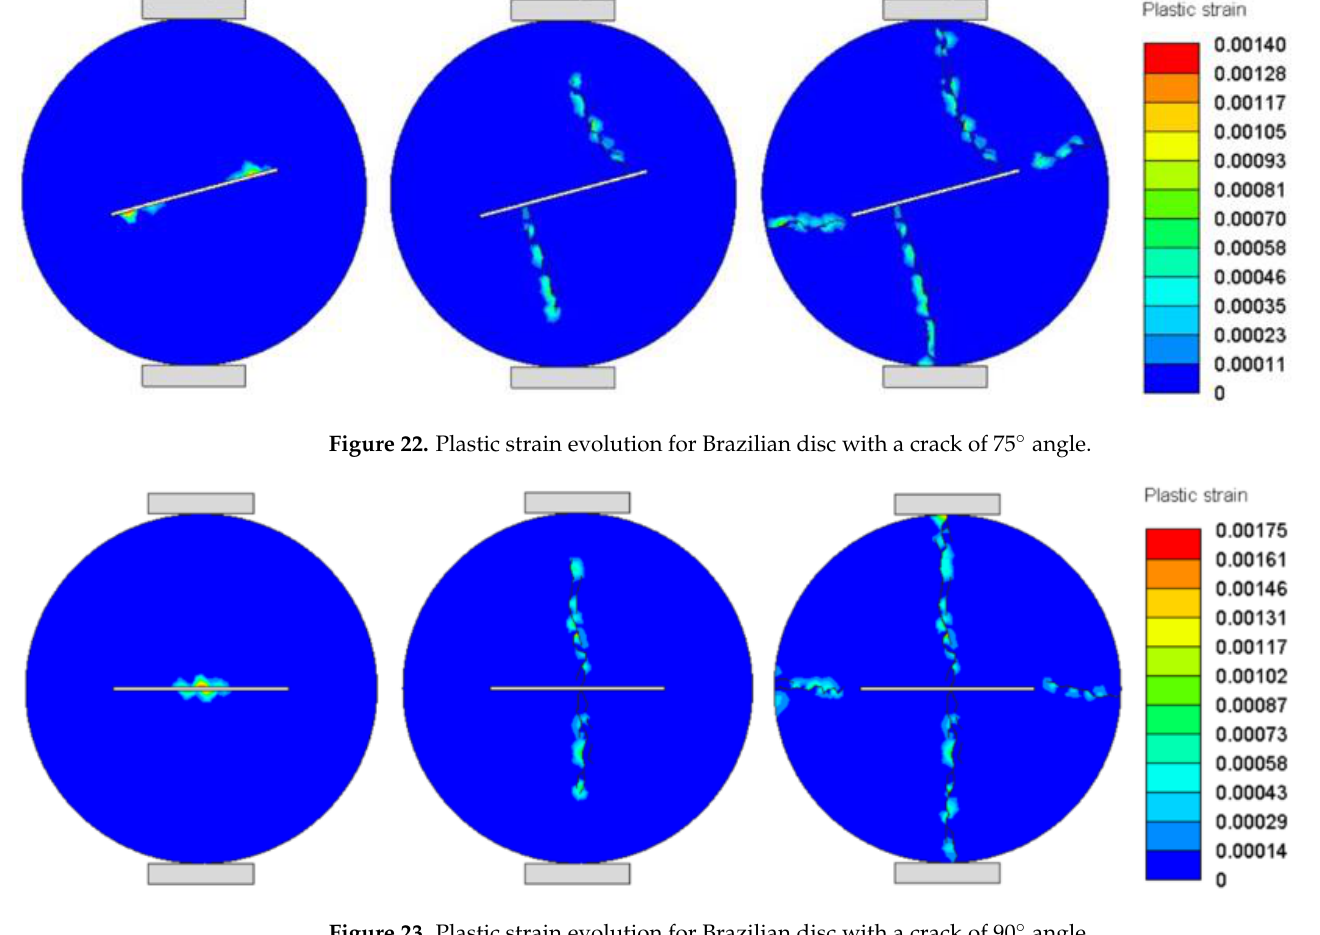
Figure 23. Plastic strain evolution for Brazilian disc with a crack of 90° angle.